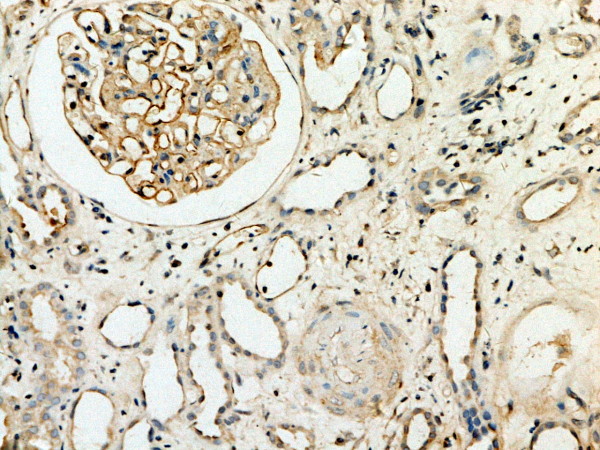
Expression of C4d and renal histology. C4d diffuse staining in glomerular and peritubular capillaries(EnVision assay; original magnification × 200).